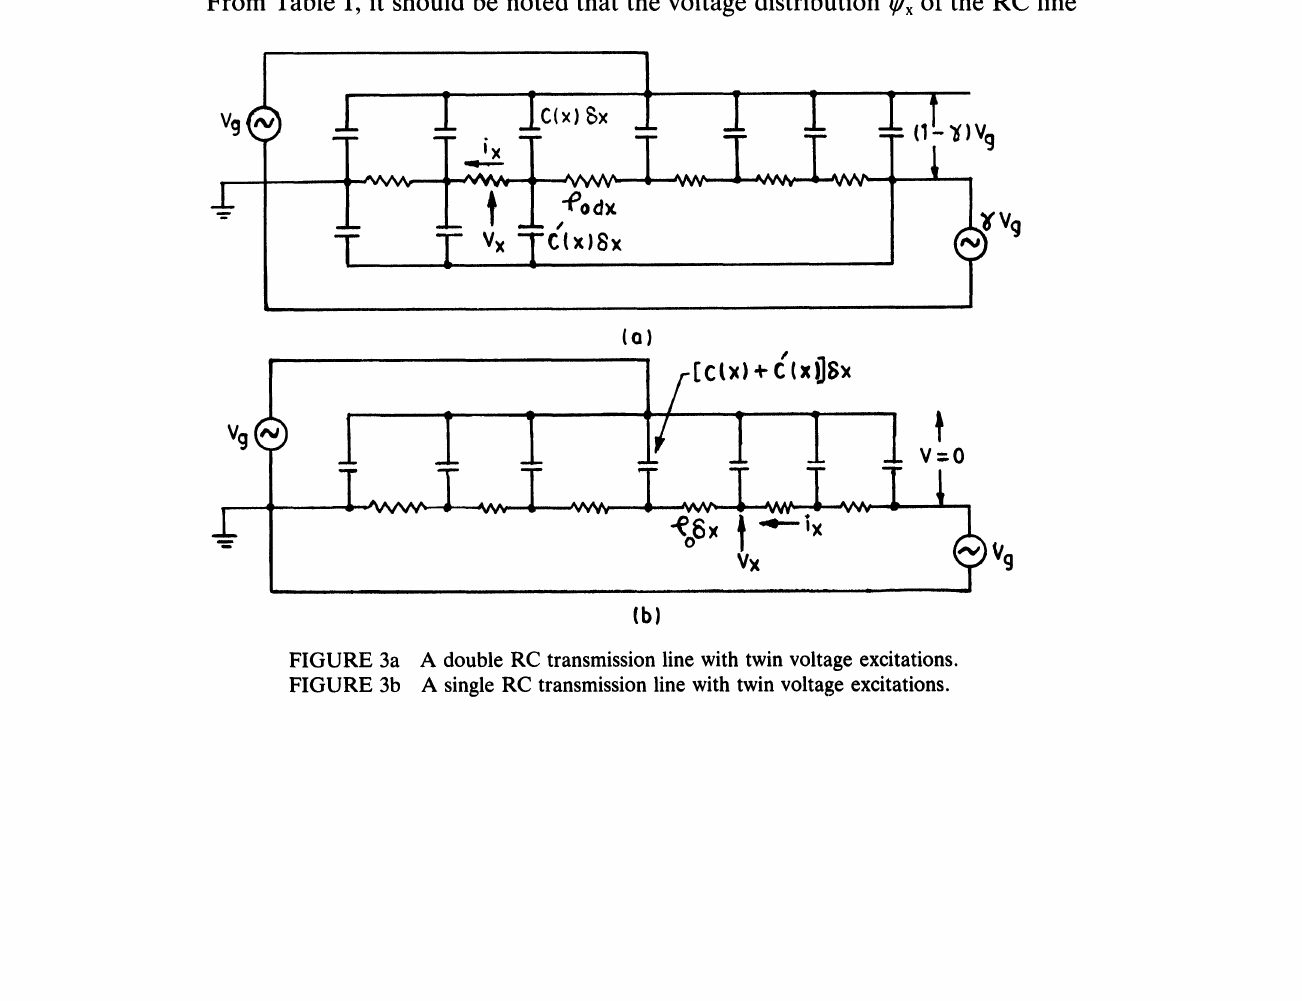
FIGURE 3a A double RC transmission line with twin voltage excitations. FIGURE 3b A single RC transmission line with twin voltage